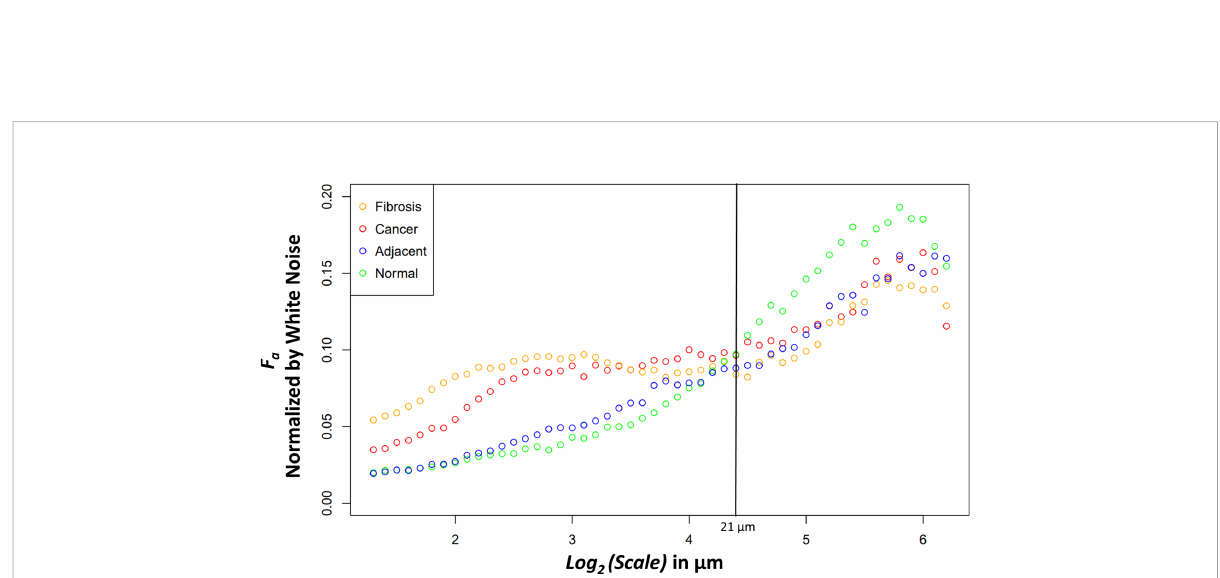
FIGURE 4 Median anisotropy factor across all images for fi brosis (orange), cancer (red), adjacent (blue), and normal (green) tissue normalized by white noise anisotropy factor from ~2.5 m m to 73.5 m m.